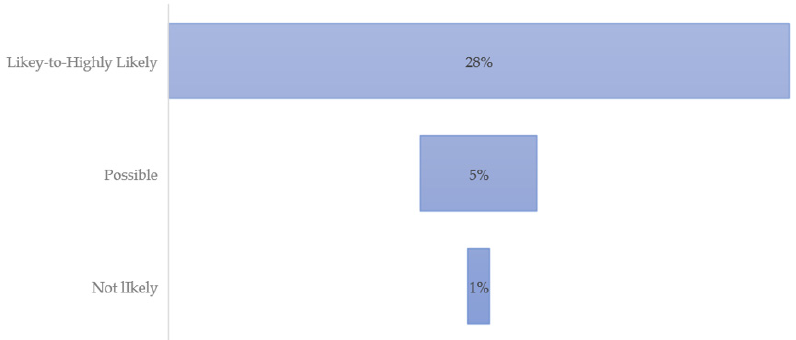
Figure 2. Percent of respondents reporting top five symptoms indicative of a TBD “All the Time”.